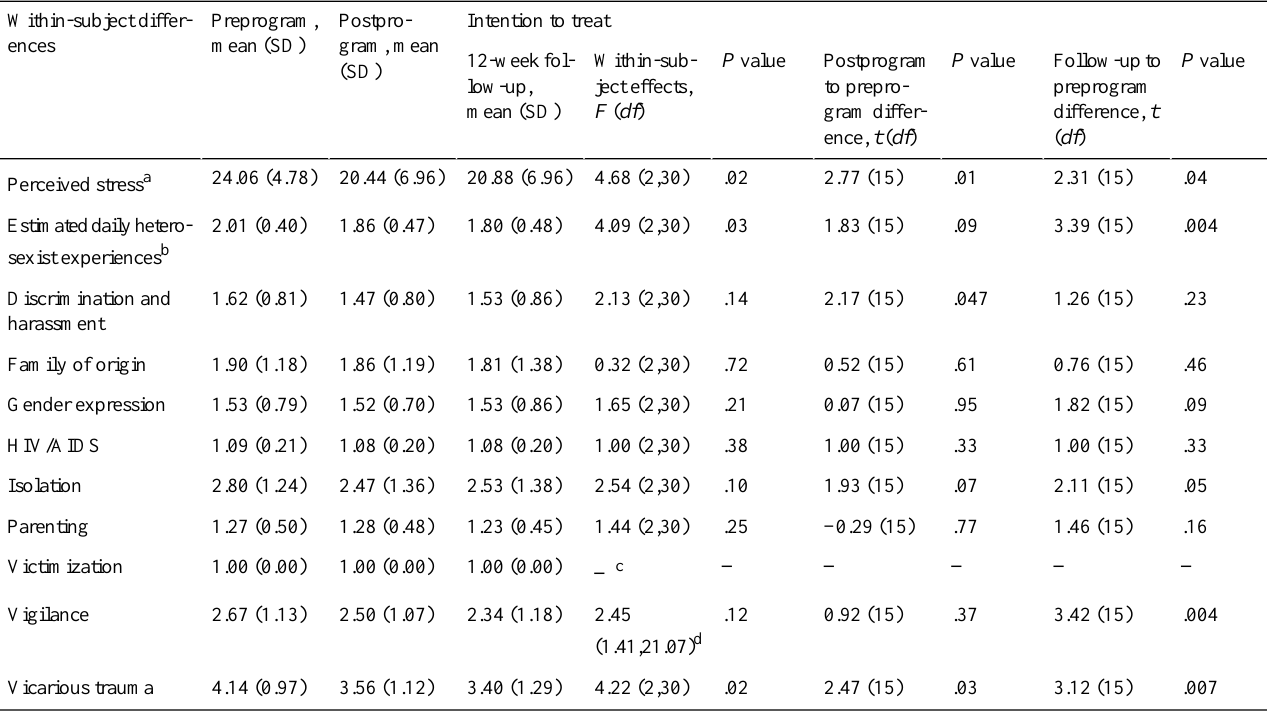
Table 4. Within-subject differences in perceived and minority stress in lesbian and bisexual women participating in online mindfulness-based stress reduction by intention-to-treat analyses.